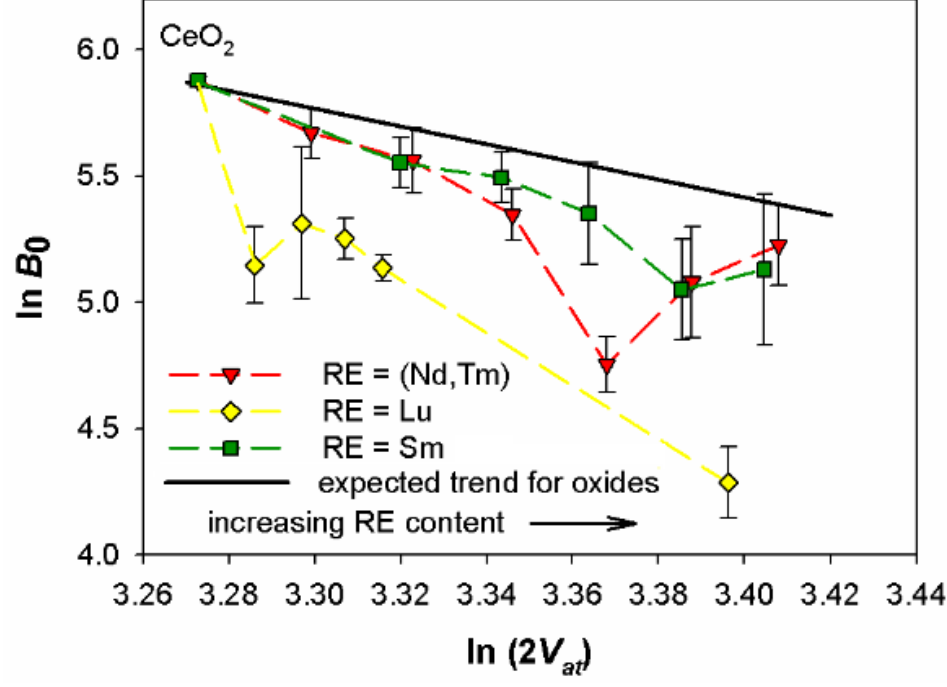
Figure 6. Trend of lnB 0 vs. ln ( 2 V at ) for all the studied systems. Data of CeO 2 are taken from [88], while the ones of the Sm- and (Nd,Tm)-containing systems derive from [13]; experimental points of Lu-doped ceria are taken from [12]. Cell volumes of samples crystallizing in the F phase are multiplied by 8 in order to make them comparable with those crystallizing in the C structure.